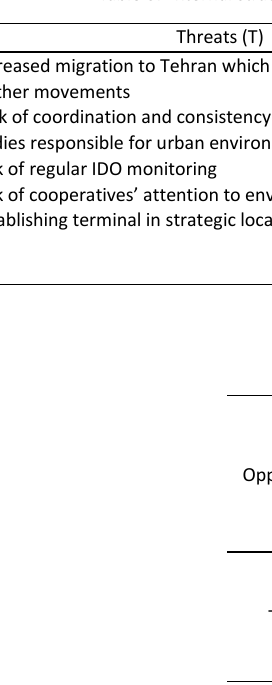
Table 8: External strategic factors of SWOT model in West Bus Terminal environmental management